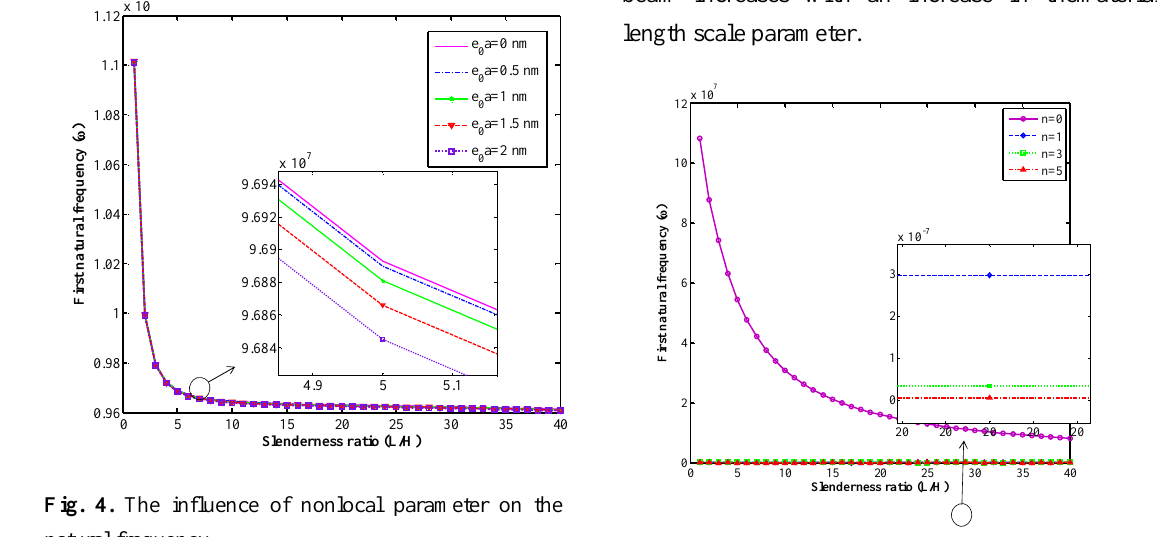
Fig. 6. The influence of power law index on the natural frequency.